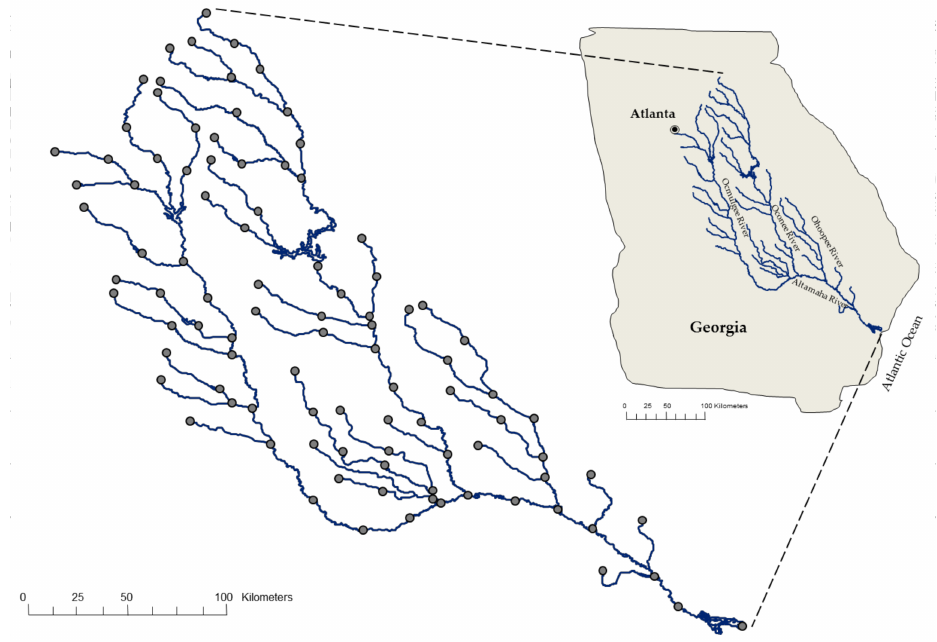
Figure 7. Shape of the Altamaha river